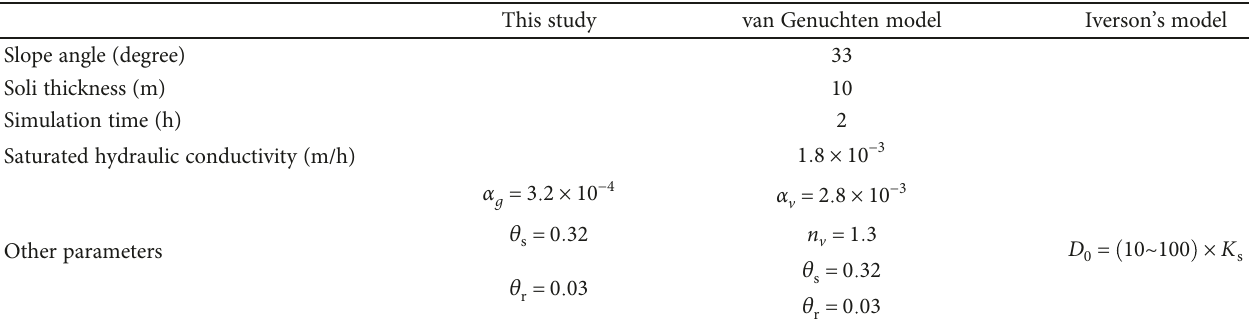
Table 2: Unsaturated soil parameters used in the comparison example. This